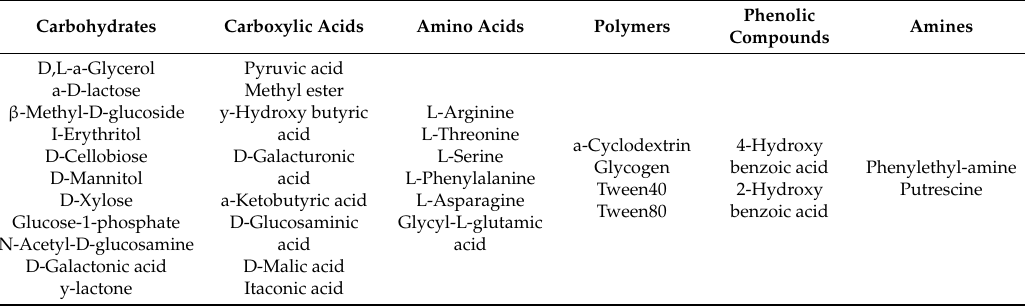
Table 1. Sole carbon substrates in BIOLOG used in the present work